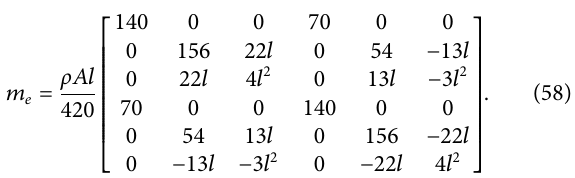
of EL Centro seismic waves conforms to the laws of the dynamic response of the structure discussed in cases 1 to 8.